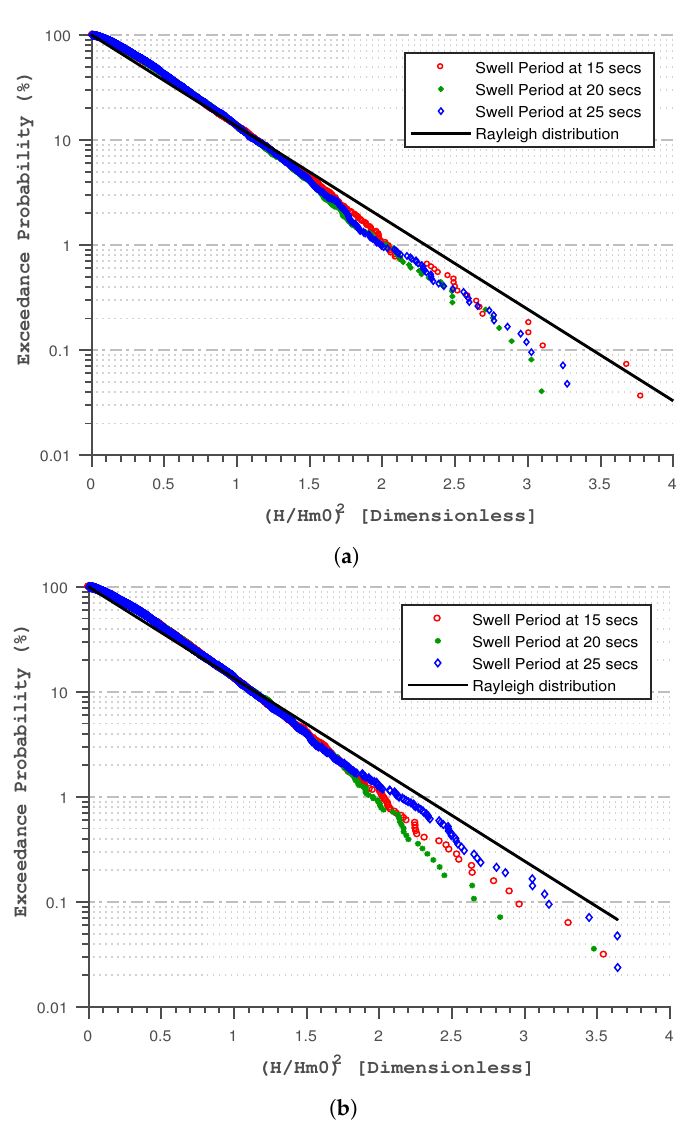
Figure 7. Effects of swell periods on wave height distribution near and away from the structure. ( a ) Wave height distribution for different swell periods observed away from the structure; ( b ) Distribution of wave height for different swell periods observed near the